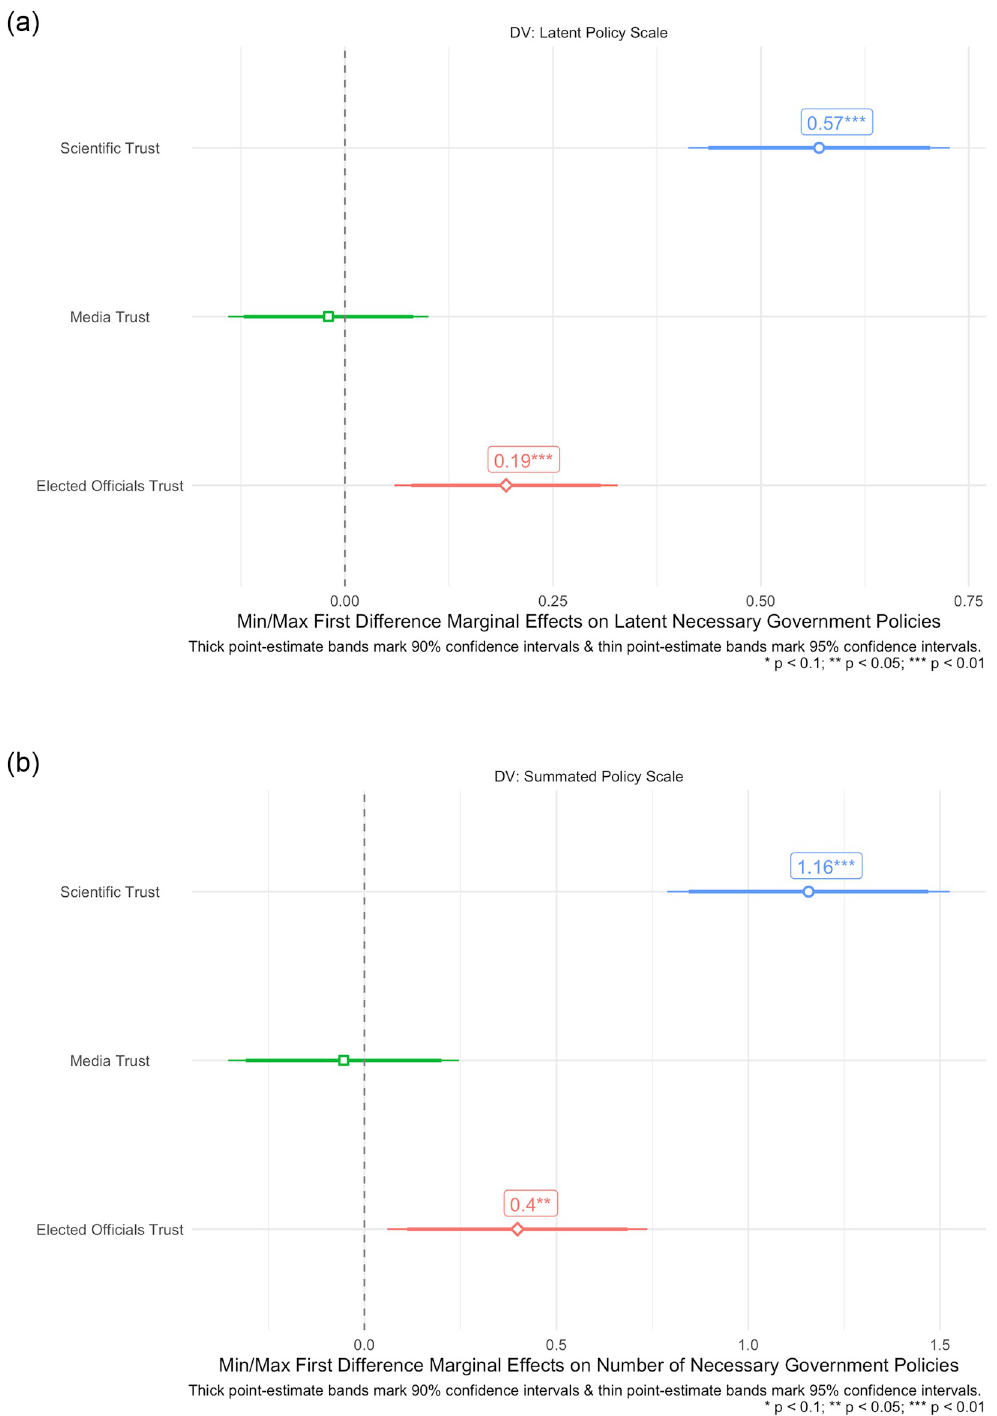
Fig 4. Baseline OLS model effects of scientific, media, & institutional trust on composite COVID-19 social distancing policy support. A: Latent policy measure. B: Summated policy support.